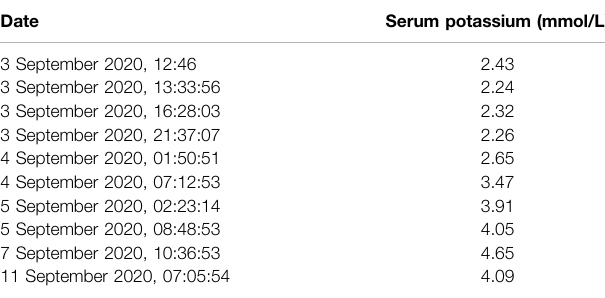
TABLE 2 | Change in serum potassium values over